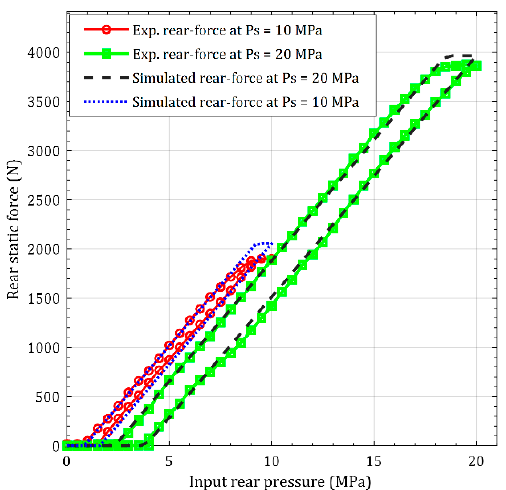
Figure 14. Comparison of the measured and theoretically predicted nonlinear static force characteristics of the actuator for pressurized flow supplied to the rear chamber.